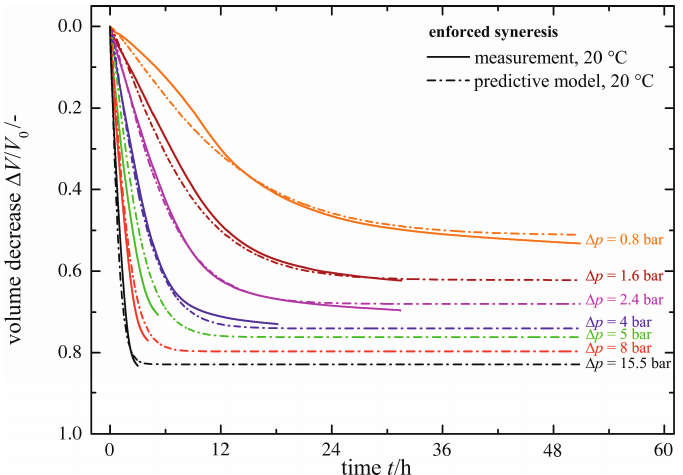
Figure 11. Comparison between measured and predicted progress of enforced syneresis for ϑ = 20